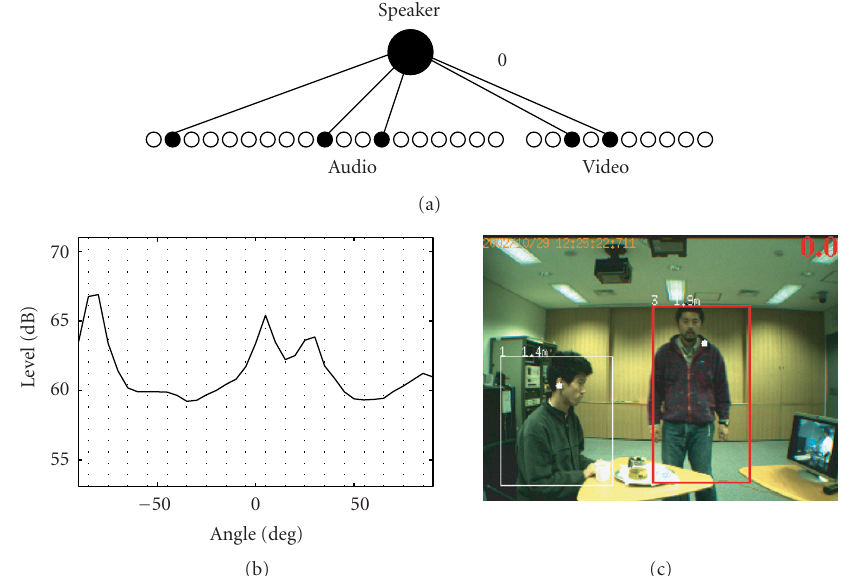
Figure 4: Example of a state of the Bayesian network and the corresponding audio and video information. (a) Bayesian network state; (b) sound localization; and (c) human